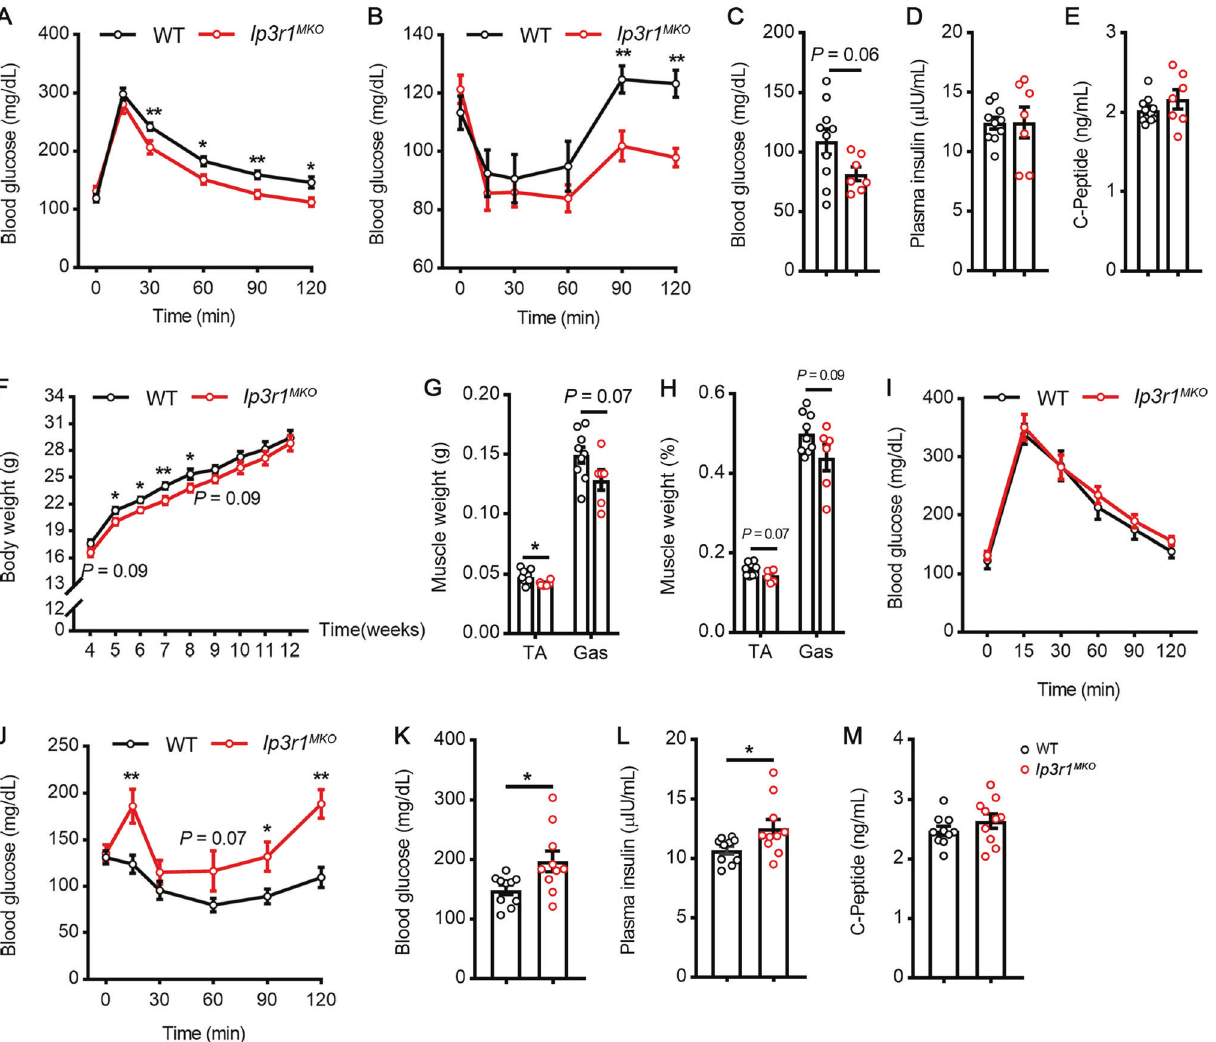
Fig. 3 Role of IP3R1 in skeletal muscle in controlling systemic glucose homeostasis of mice maintained on chow diet (CD) or high-fat diet (HFD). A GTT (2 g/kg glucose, i.p.), B ITT (1U/kg insulin, i.p.), C blood glucose levels, D plasma insulin levels, and E plasma C-peptide levels after 8 wk of CD feeding ( n = 7 – 10). F Growth curve of body weight during the 8 wk of HFD feeding ( n = 10-11). G Muscle weight, H muscle weight percentage, I GTT (2 g/kg glucose, i.p.), J ITT (1U/kg insulin, i.p.), K blood glucose levels, L plasma insulin levels, and M plasma C-peptide levels after 8 wk of HFD feeding. N = 6 – 9 for G and H , n = 10-11 for I and J , and n = 10 for K – M . All Data are presented as means ± SEM. * P < 0.05, ** P < 0.01. A , B , I , J : two-way ANOVA followed by Bonferroni ’ s post hoc test; C – H , K – M : two-tailed unpaired Student ’ s t IP3R1 regulates AMPK signaling in white adipose tissues To further understand the role of adipocyte IP3R1 in regulating metabolic homeostasis, AMPK signaling was measured by western blotting. Following feeding with HFD for 8 wk, WT and Ip3r1 FKO mice showed similar phosphorylation levels of AMPK and ACC in iWAT (Fig. 7A – C). Strikingly, eWAT from Ip3r1 FKO mice showed increased levels of p-AMPK (T172) and decreased levels of p-ACC (S79) compared to WT mice (Fig. 7D – F). Thus, IP3R1 activates AMPK signaling in visceral fat but not subcutaneous fat in mice offered HFD.